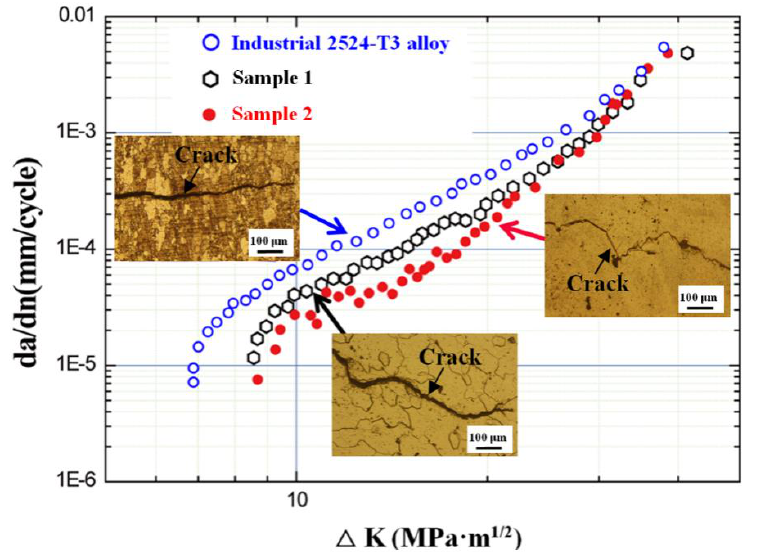
Figure 15. Fatigue crack growth rates (FCGRs) vs. applied ∆ K of Sample 1 and 2, and an industrial 2524-T3 alloy.